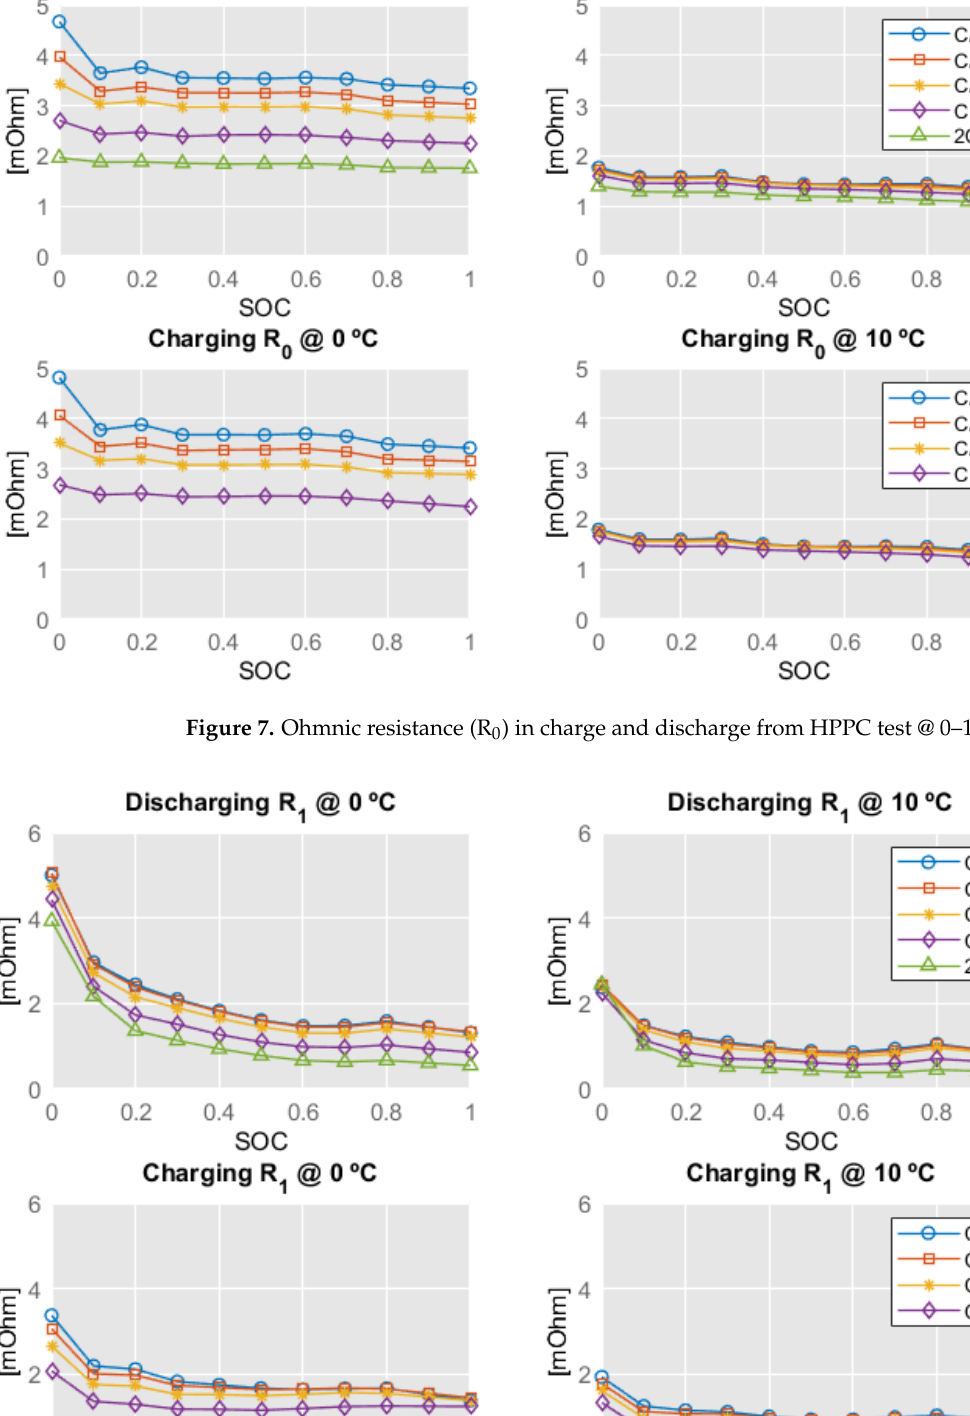
Figure 6. Open circuit voltage V OC test results.